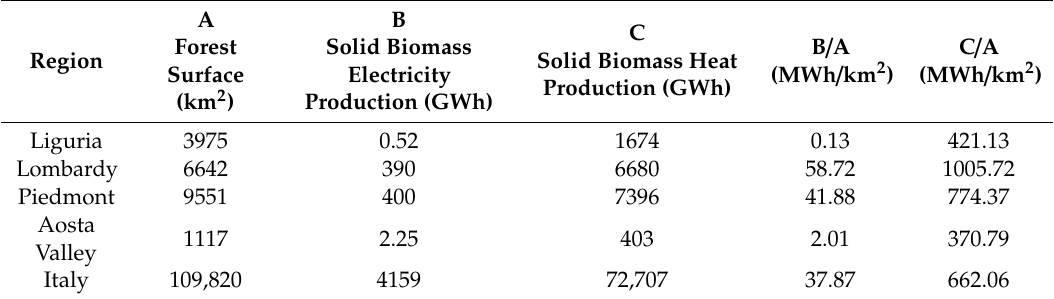
Table 6. Solid biomass energy generation and forest surface in Northwest Italy (2018